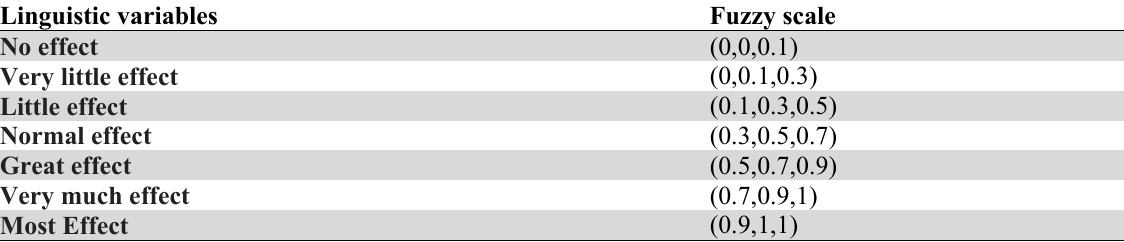
Define fuzzy scales for linguistic variables Linguistic